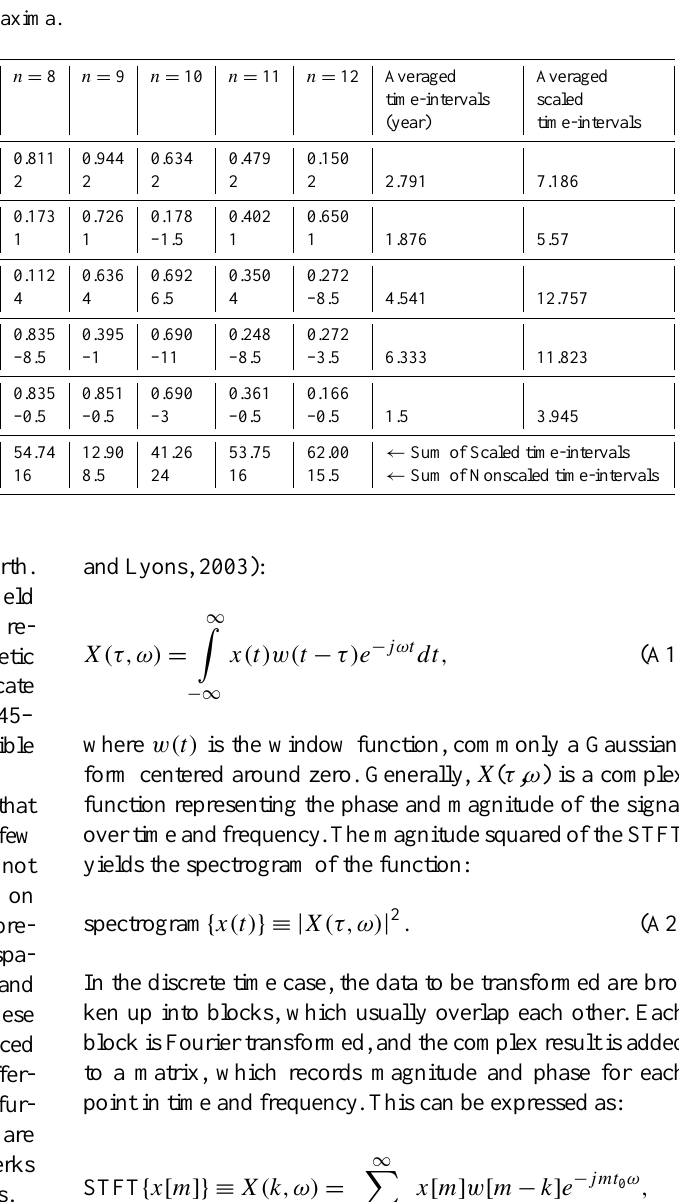
Averaged time-intervals scaled (year)